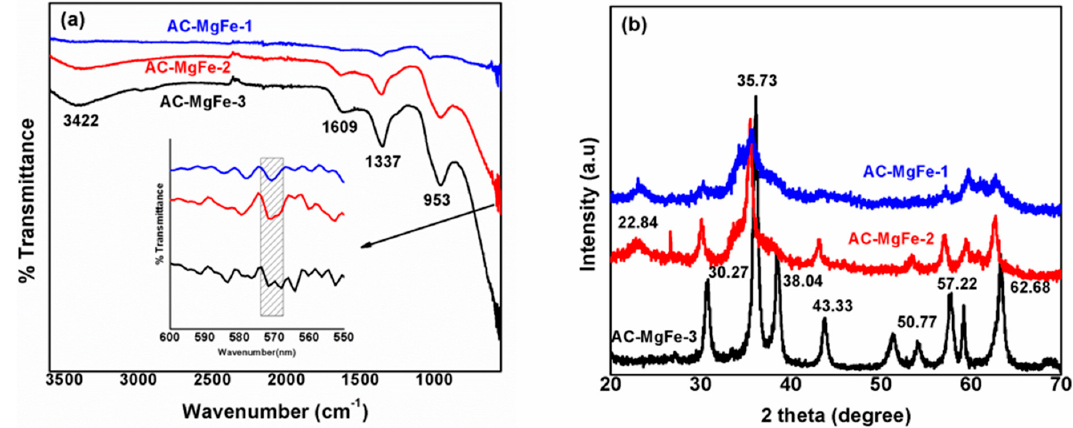
Figure 1. FTIR spectra of AC–MgFe composites ( a ), XRD pattern of AC–MgFe composites ( b ).